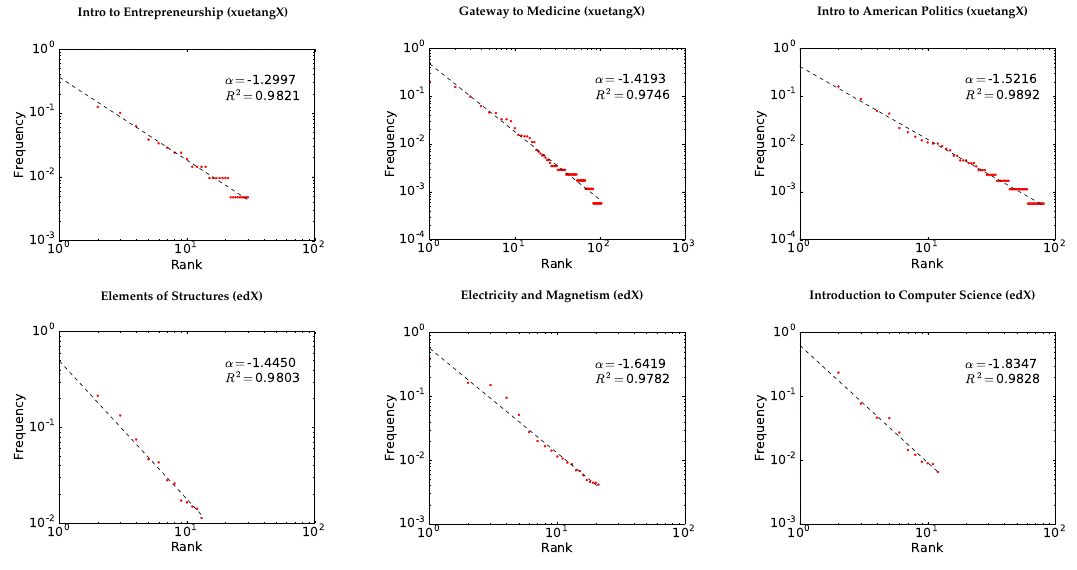
Figure 4. Linear regression results of six